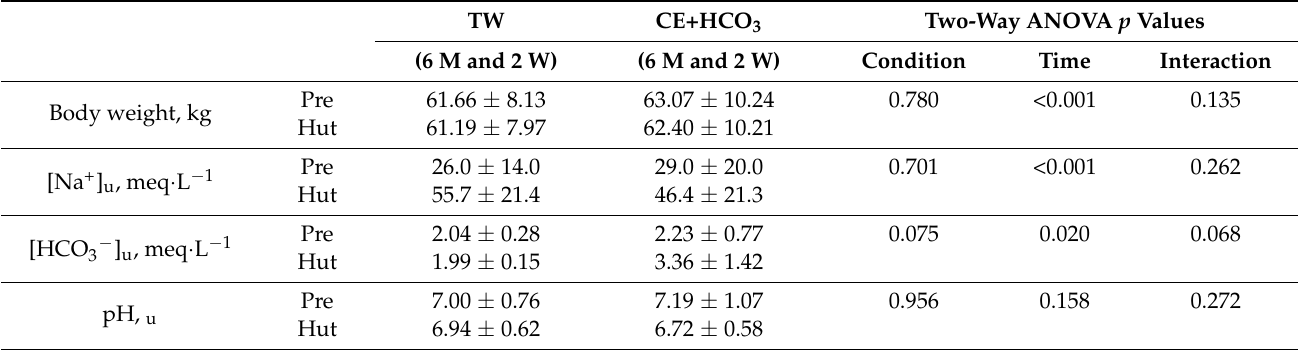
Table 3. Changes in body weight and urine variables between pre-trekking and at the hut.